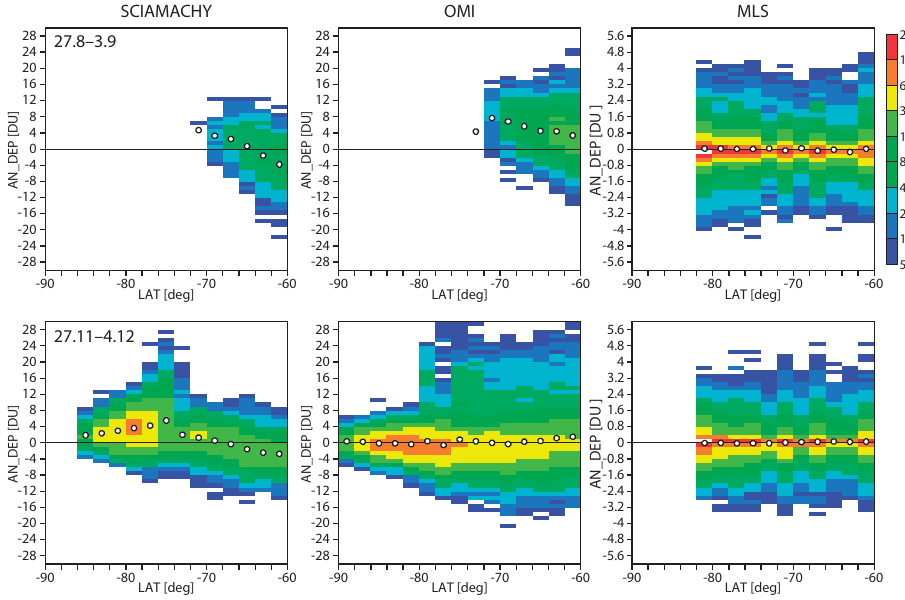
Fig. 3. Frequency distribution of analysis departures (observation minus analysis) from IFS-MOZ-ANA (see table 2) inDU (vertical axis) against latitude (horizontal axis) for total column observations from SCIAMACHY (left) and OMI (middle) and partial columns observations from MLS (right, different y-axis range) over Antarctica (60 ◦ S–90 ◦ S) in the period from 27 August to 3 September 2008 (top) and from 27 November to 4 December 2008 (bottom). The circles show the average for each latitude